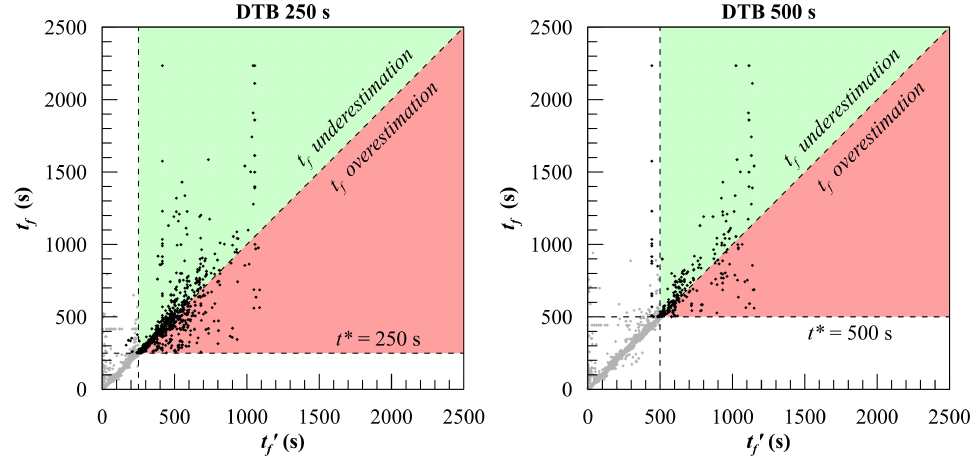
Figure 11. Predicted over observed values of the time-to-flood computed at 250 s and 500 s from damage occurrence according DTB method. Training: MC20; validation: MC50b.